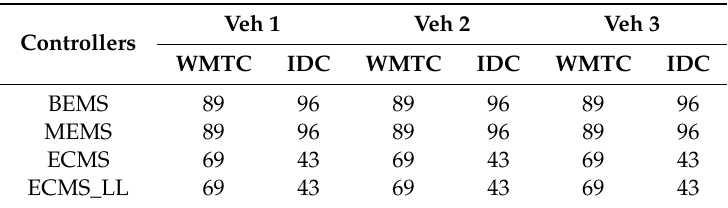
Table 5. Engine switching event for di ff erent controllers tested for di ff erent vehicle configurations (Veh1, Veh2 and Veh3) and test cycles (WMTC and IDC).